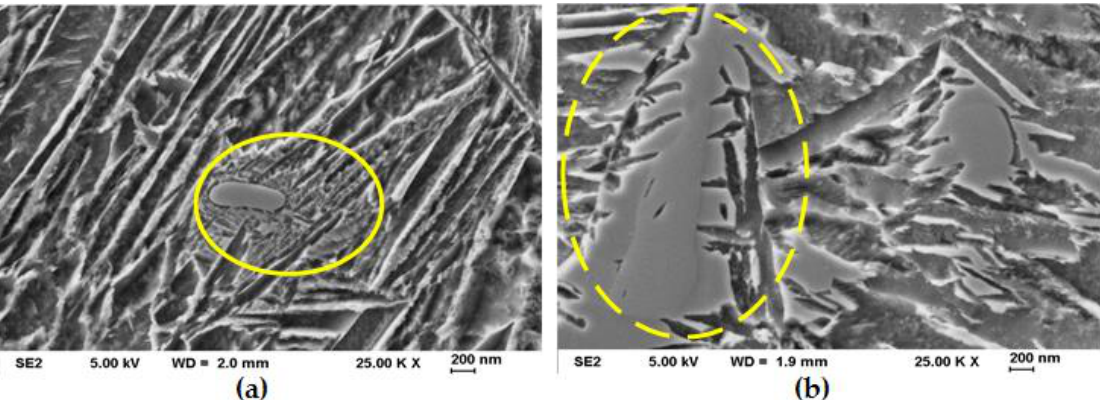
Figure 13. Microstructural comparison of runouts of ( a ) QP1 and ( b ) QP2.